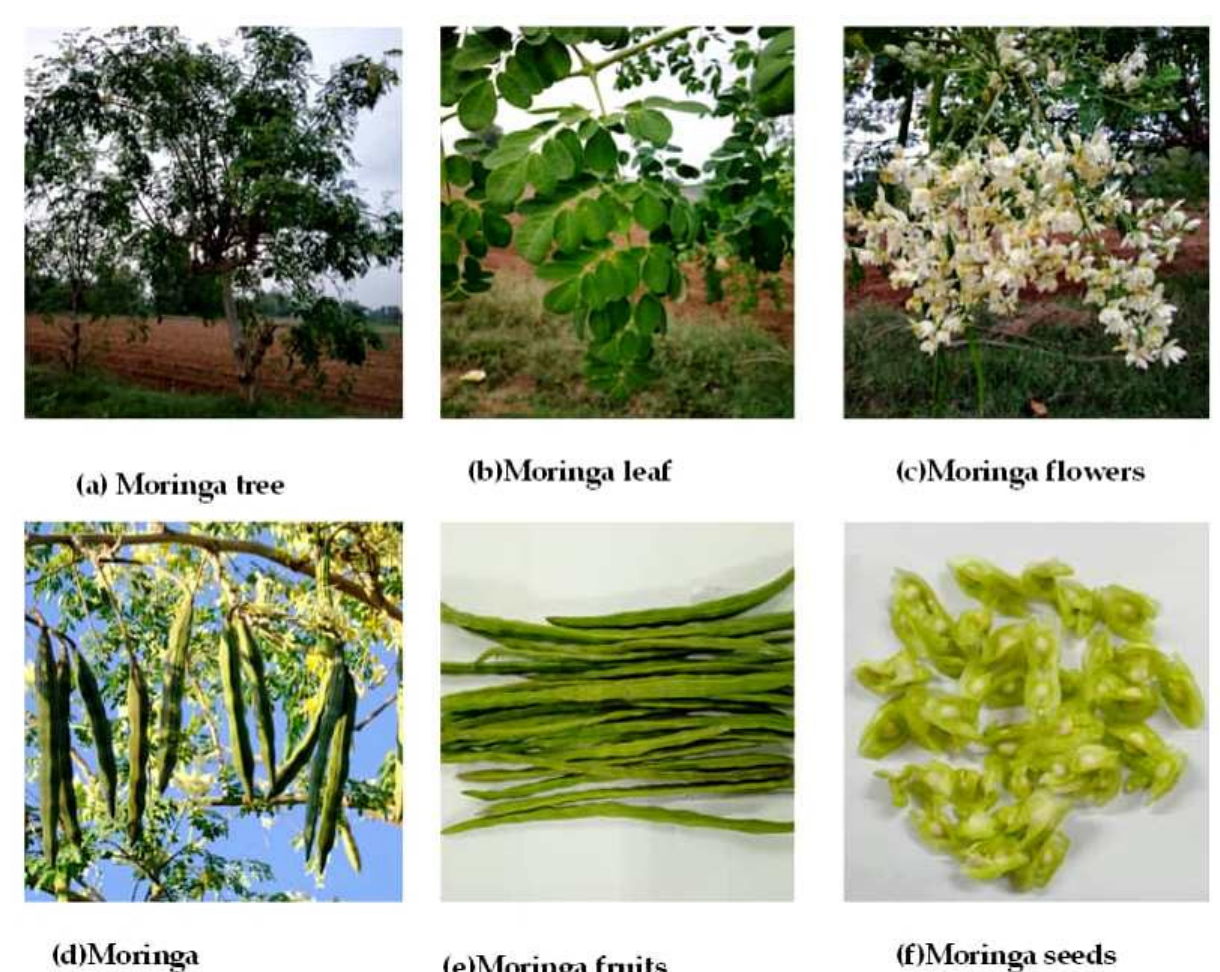
Figure 2. ( a – f ). Different economic plant parts of